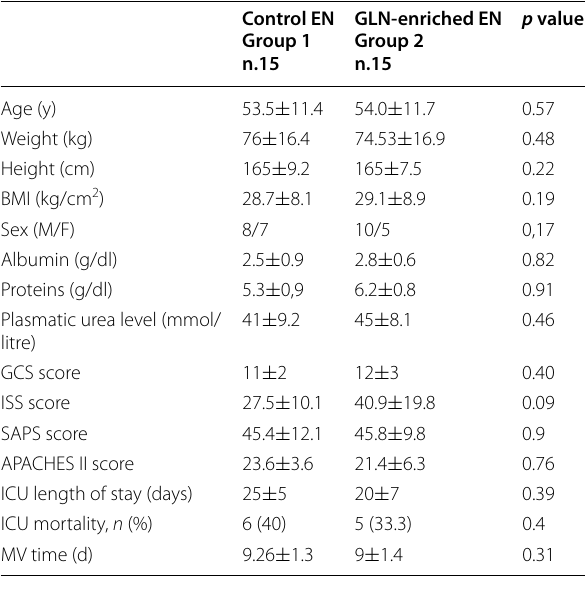
Table 1 Demographic, laboratory and clinical characteristics